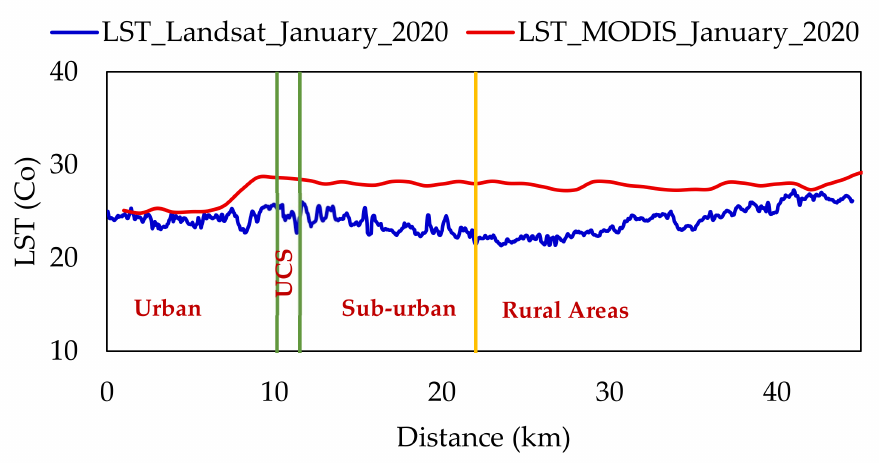
Figure 17. Spatial progression of Profile 1 in daytime LST of winter